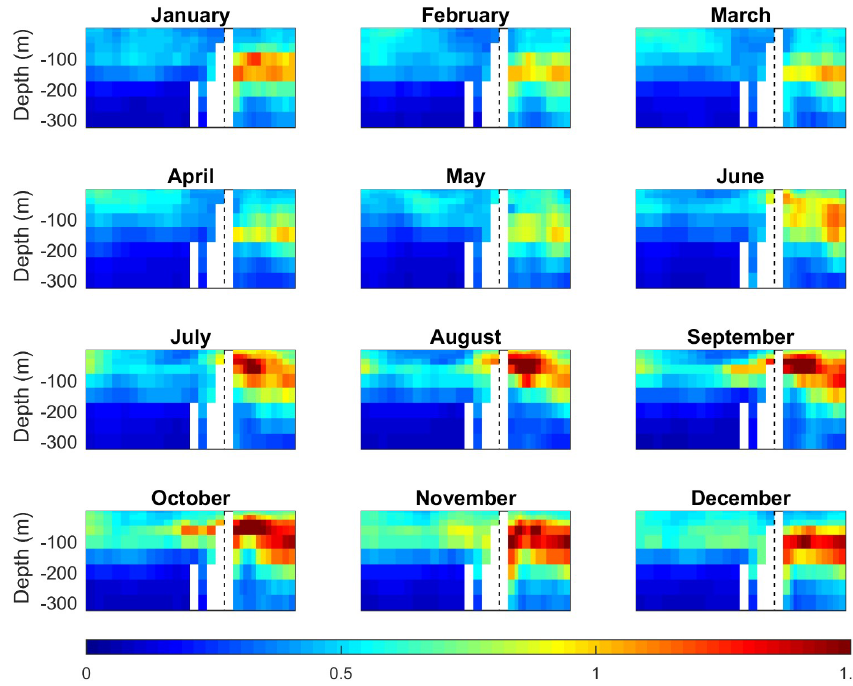
Figure 18. Vertical section along the Red Sea and Gulf of Aden of the SD of interannual variations per month (in ◦ C).